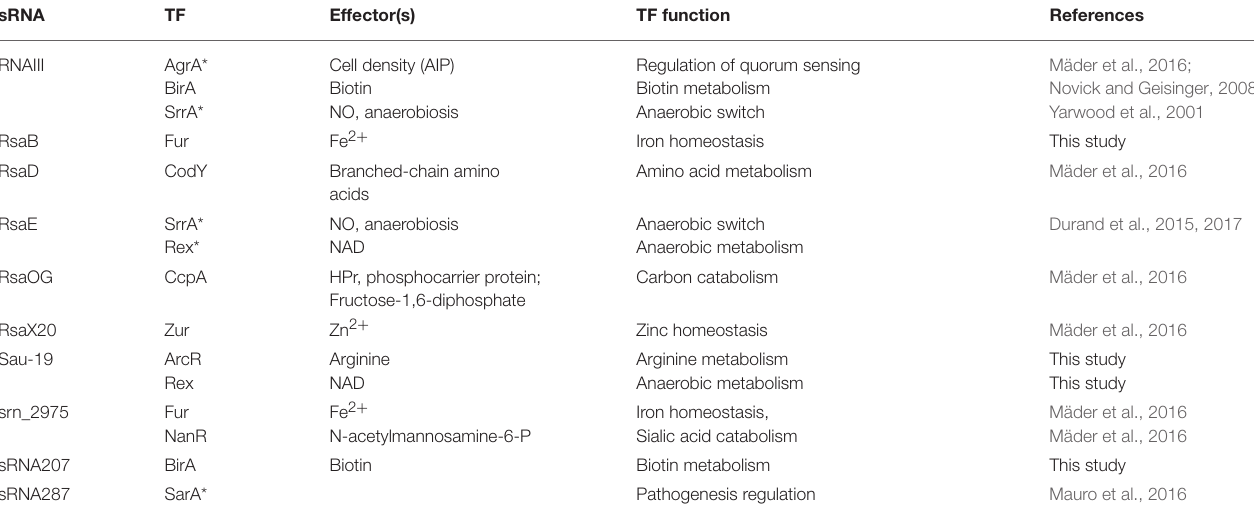
TABLE 3 | List of transcription factor motifs found by MAST analysis ( E -value < 0.01) in the putative promoter region ( − 100 to + 50 nts from transcription start sites) of bona fide